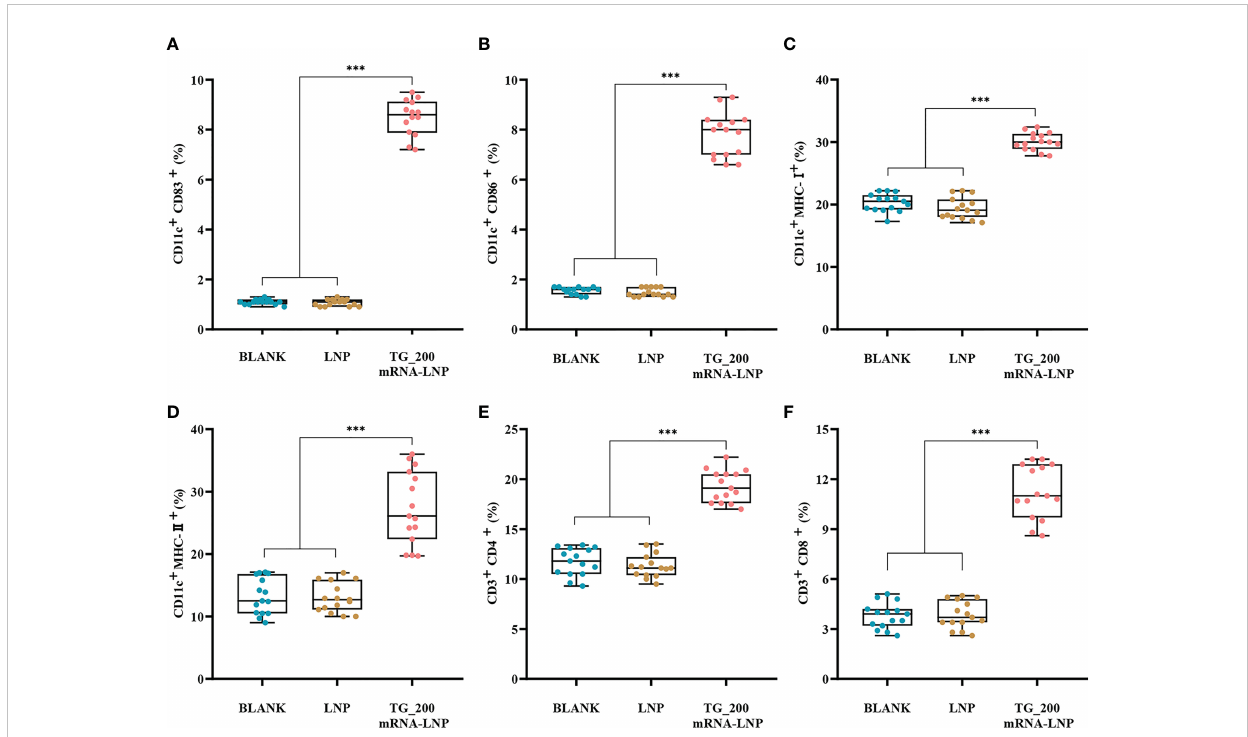
FIGURE 7 Flow cytometry analysis of dendritic cells (DCs) and T lymphocytes in immunized BALB/c mice. (A) The box graph shows the percentages of CD11c + CD83 + DCs in mice splenocytes. (B) The box graph shows the percentages of CD11c + CD86 + DCs in mice splenocytes. (C) The box graph shows the percentages of CD11c + MHC-I + DCs in mice splenocytes. (D) The box graph shows the percentages of CD11c + MHC-II + DCs in mice splenocytes. (E) The box graph shows the percentages of CD3 + CD4 + T lymphocytes. (F) The box graph shows the percentages of CD3 + CD8 + T lymphocytes. n = 5/group, *** P < 0.001. The data are shown as the means ± SD of three independent